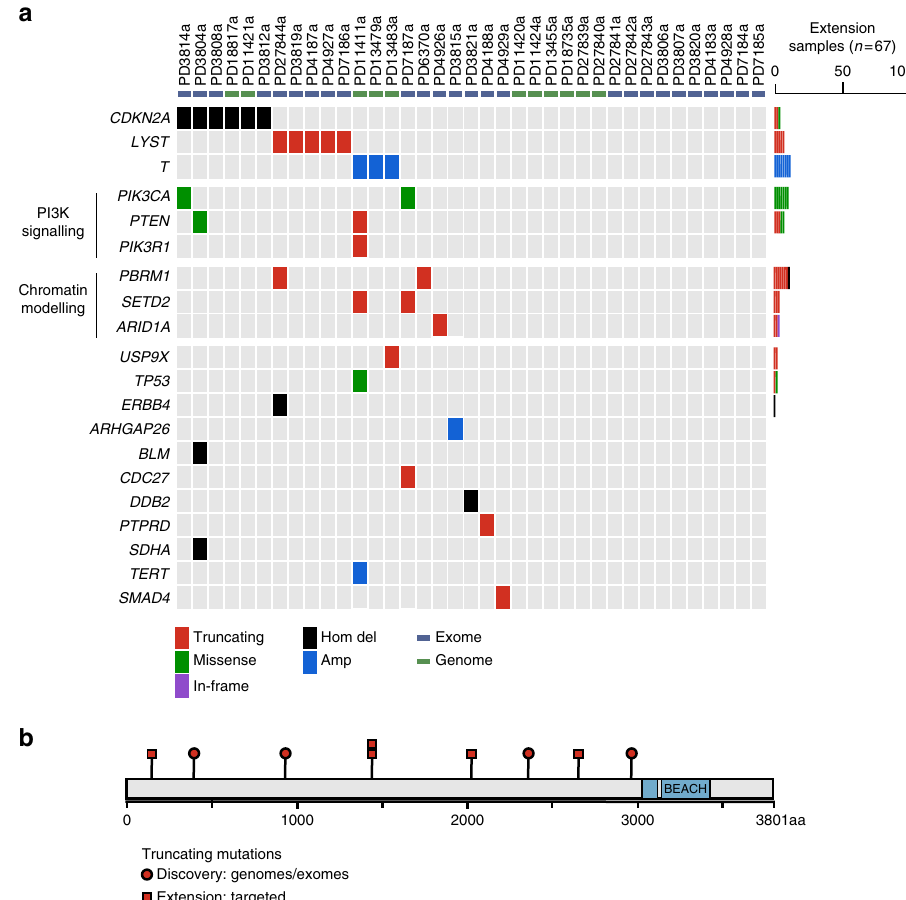
Fig. 1 Driver landscape of 104 chordomas. a For the discovery cohort, in every tumour (column), driver events are indicated by gene (row) and type of mutation (colour coded; refer to legend). For extension cases, the overall prevalence of driver events in each gene is indicated (colour coded by mutation class). b The LYST protein is depicted, indicating the position of truncating mutations in the discovery (red circles) and extension (red squares) samples. Functional domains are indicated in